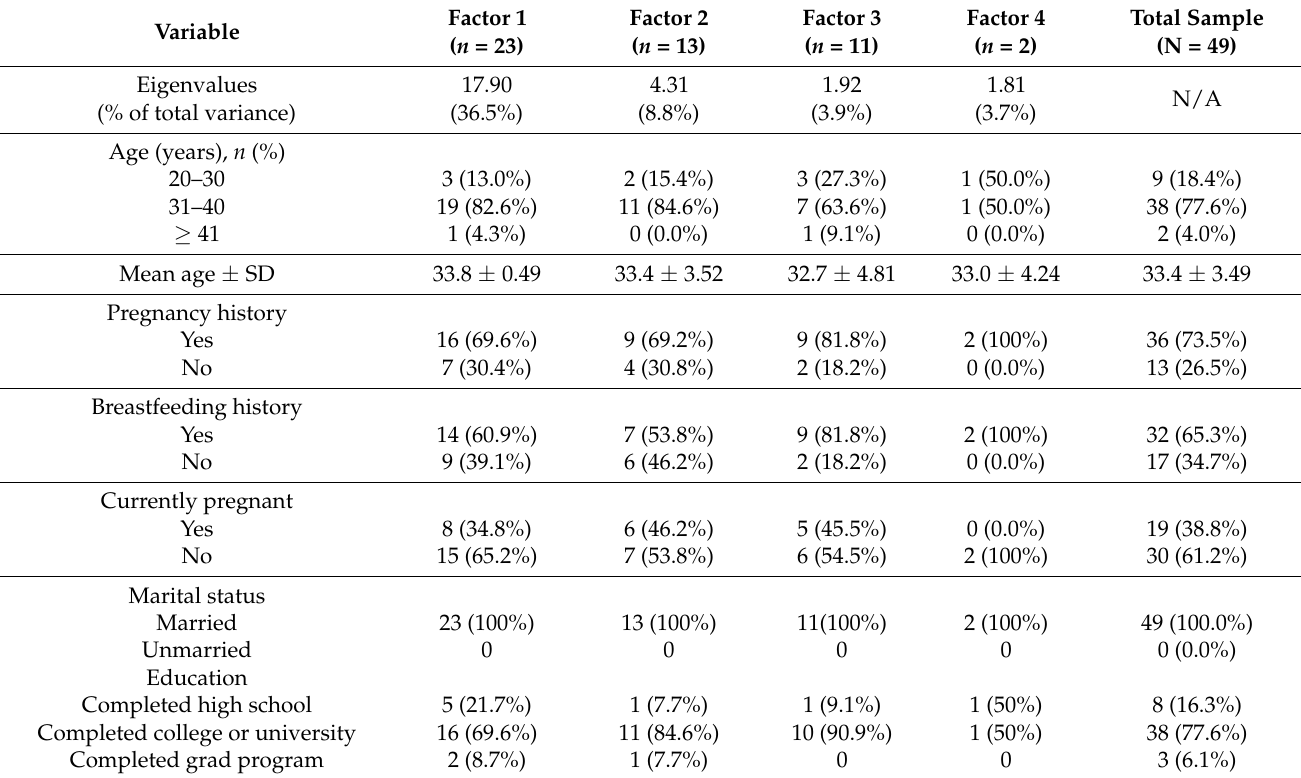
Table 1. Eigenvalues, variance, and participant